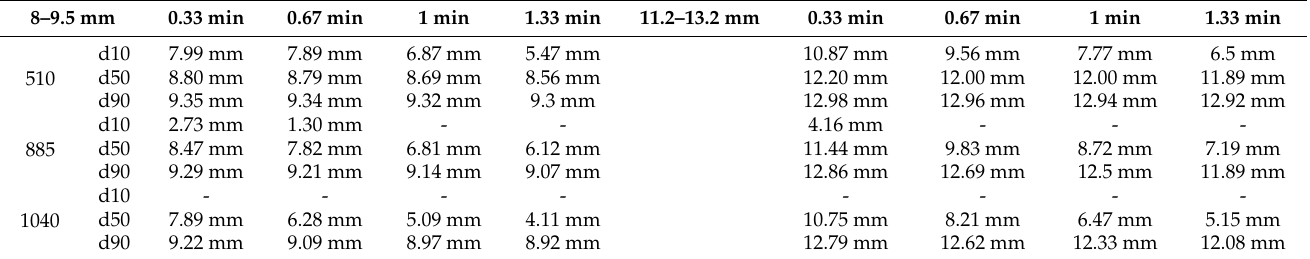
Table 5. d 10 , d 50 , and d 90 of the 8–9.5 mm and 11.2–13.2 mm